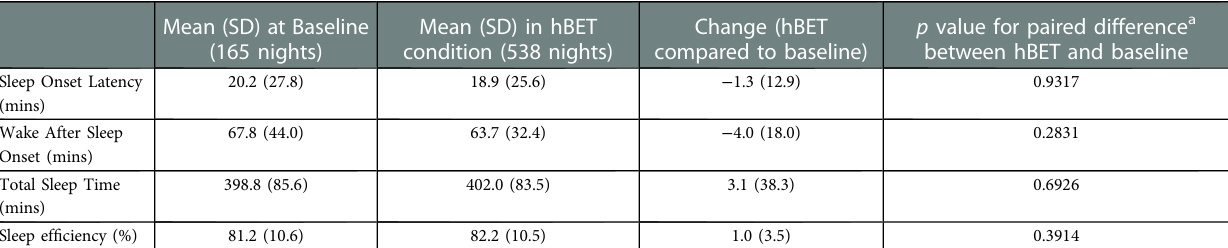
p value for paired difference